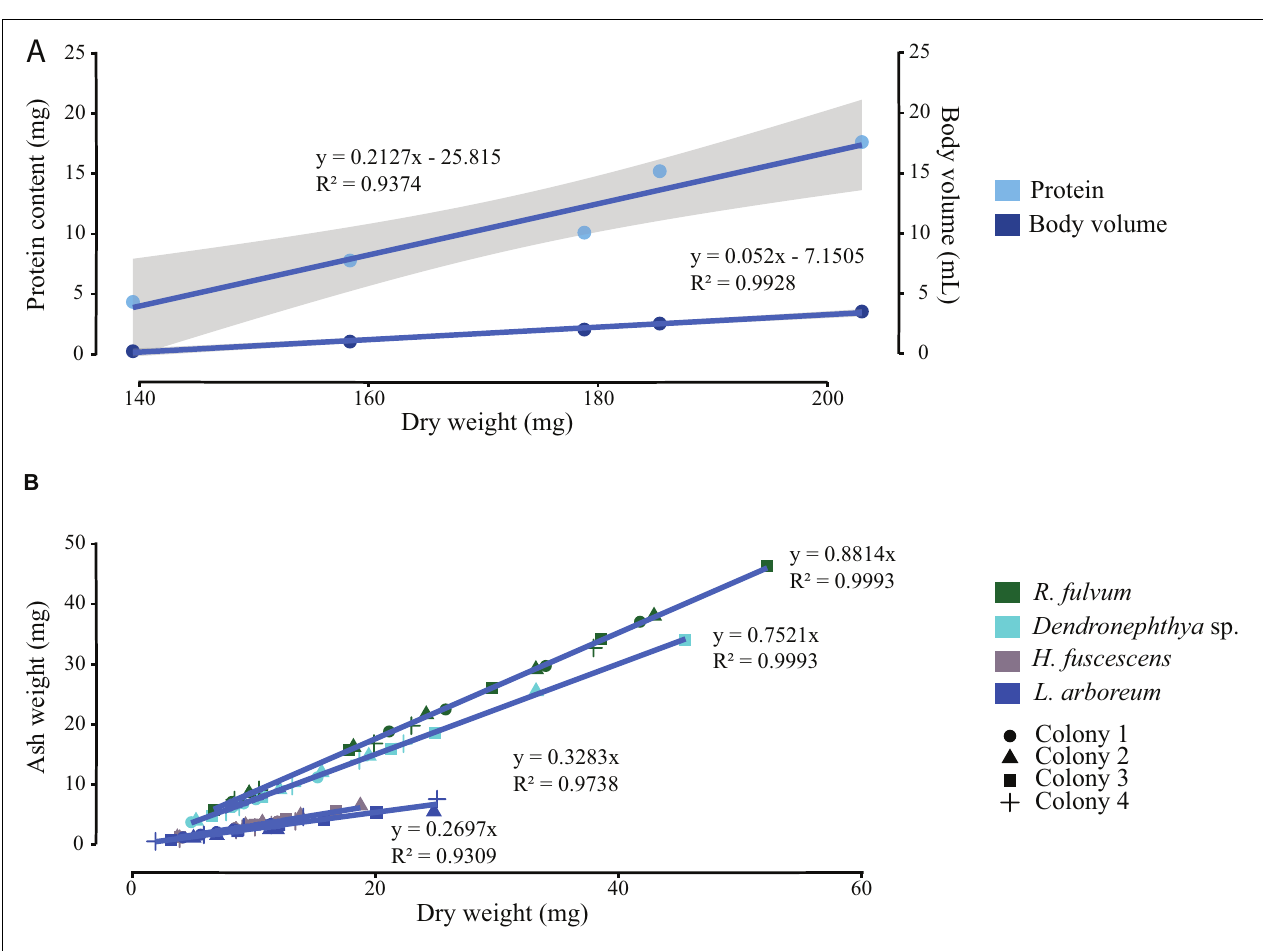
FIGURE 3 | Correlations between the normalizing metrics. (A) Total dry weight with protein content and body volume of five Heteroxenia fuscescens colonies. (B) Linear regressions between total dry weight and ash weight of four colonies of Rhytisma fulvum , Dendronephthya sp., H. fuscescens, and Litophyton arboreum. Gray areas display confidence interval of 0.95 around the regression lines.